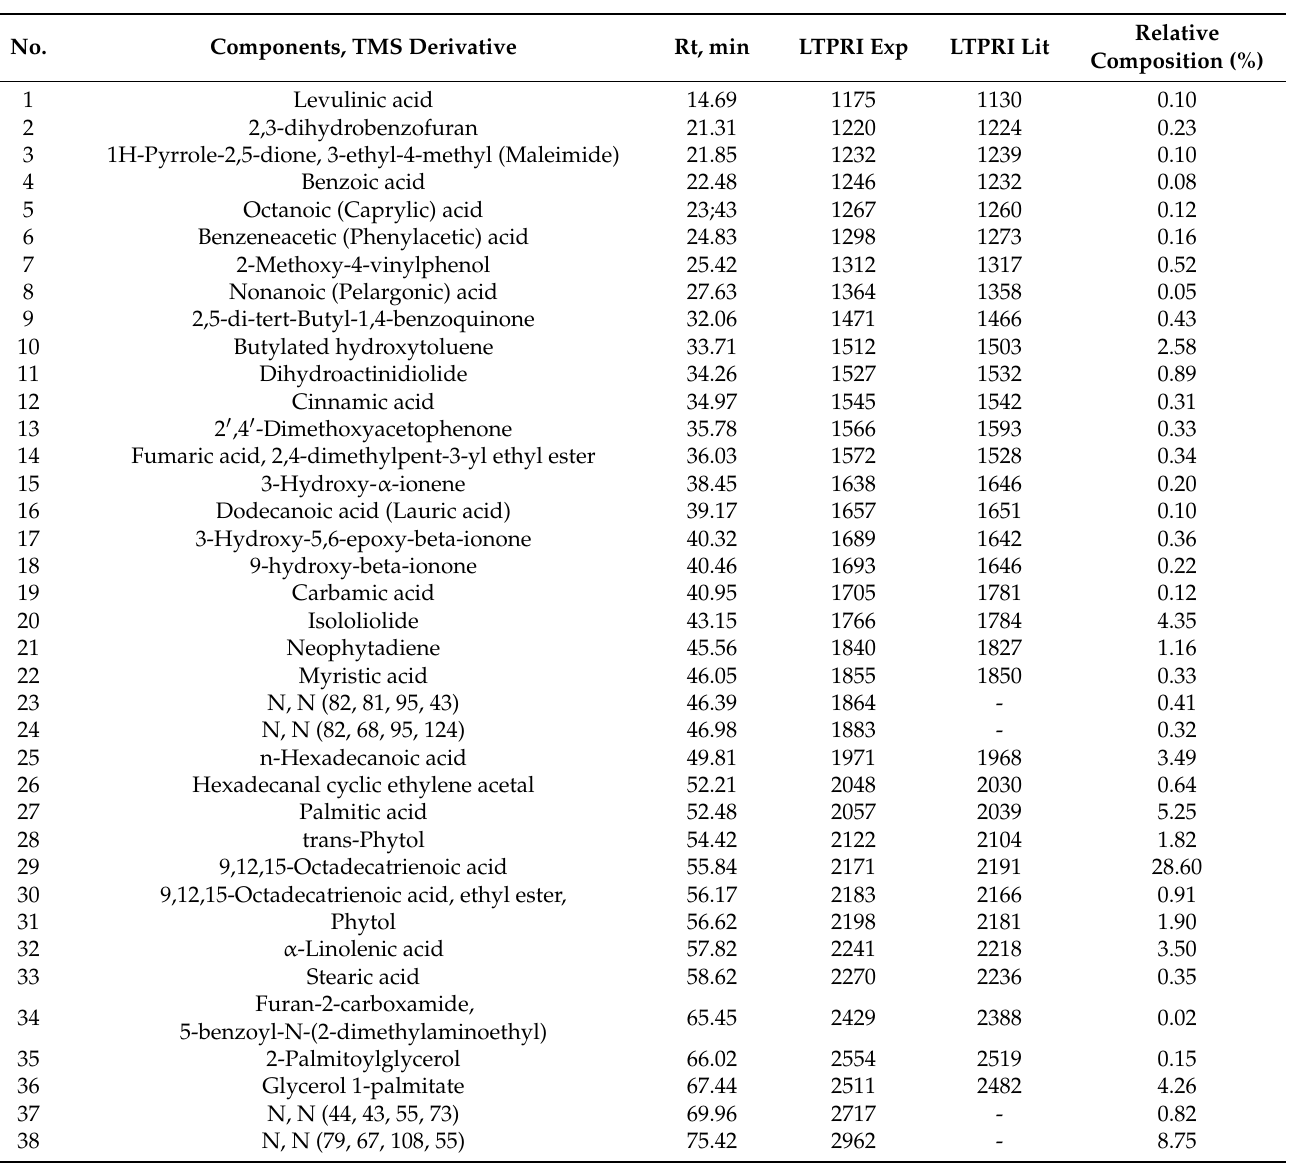
Table 6. Chemical composition of 70% ethanolic extract of young barley grass (EBG) after purified from sugar compounds.